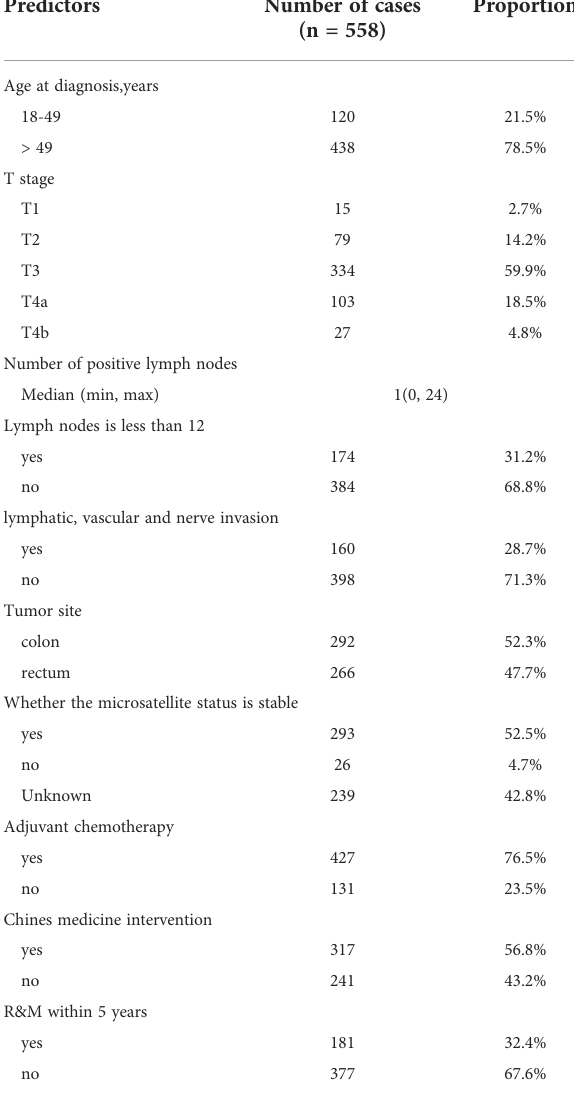
TABLE 2 characteristics of basic data of patients in model data